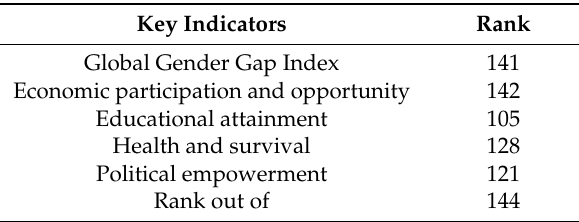
Table 1. Global gender gap index (World Economic Forum